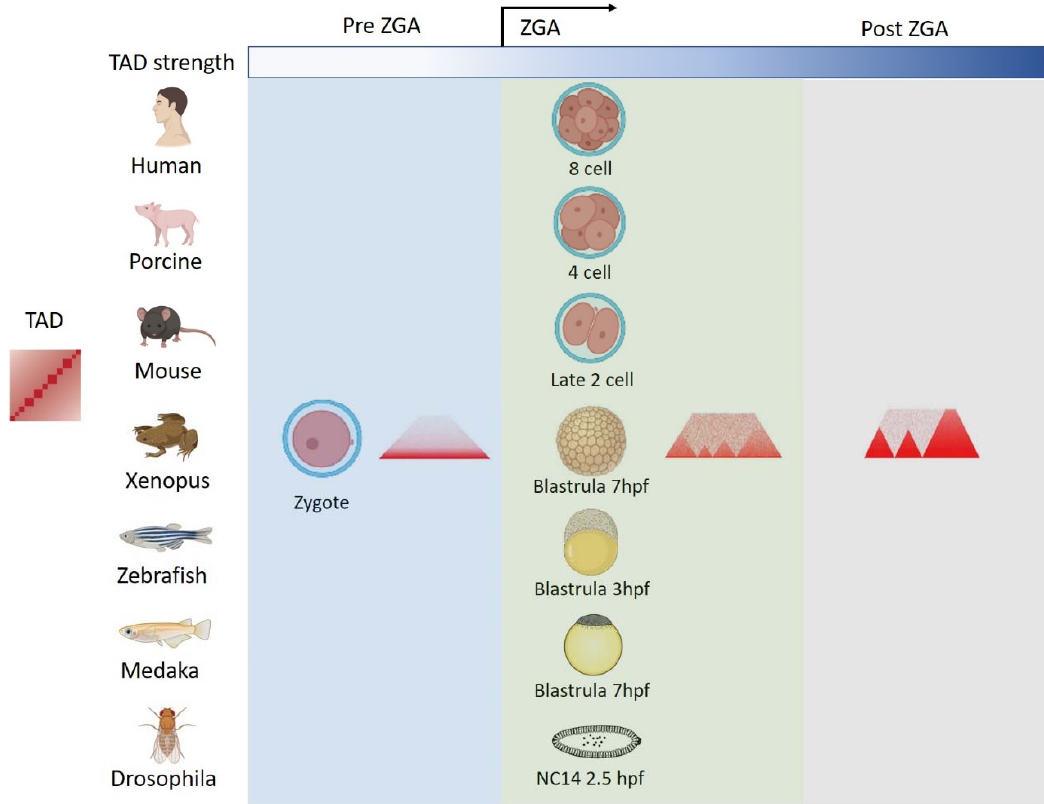
Figure 2. TAD reprogramming during the early development in different species. A schematic showing the TAD reprogramming during embryogenesis in human, porcine, mouse, zebrafish, medaka, xenopus and drosophila embryos. Overall, the establishment of TADs is coincident with the ZGA time windows in these studied organisms. Briefly, after fertilization, the TAD structures are largely lost in pre-ZGA embryos and then gradually established in post-ZGA embryos.